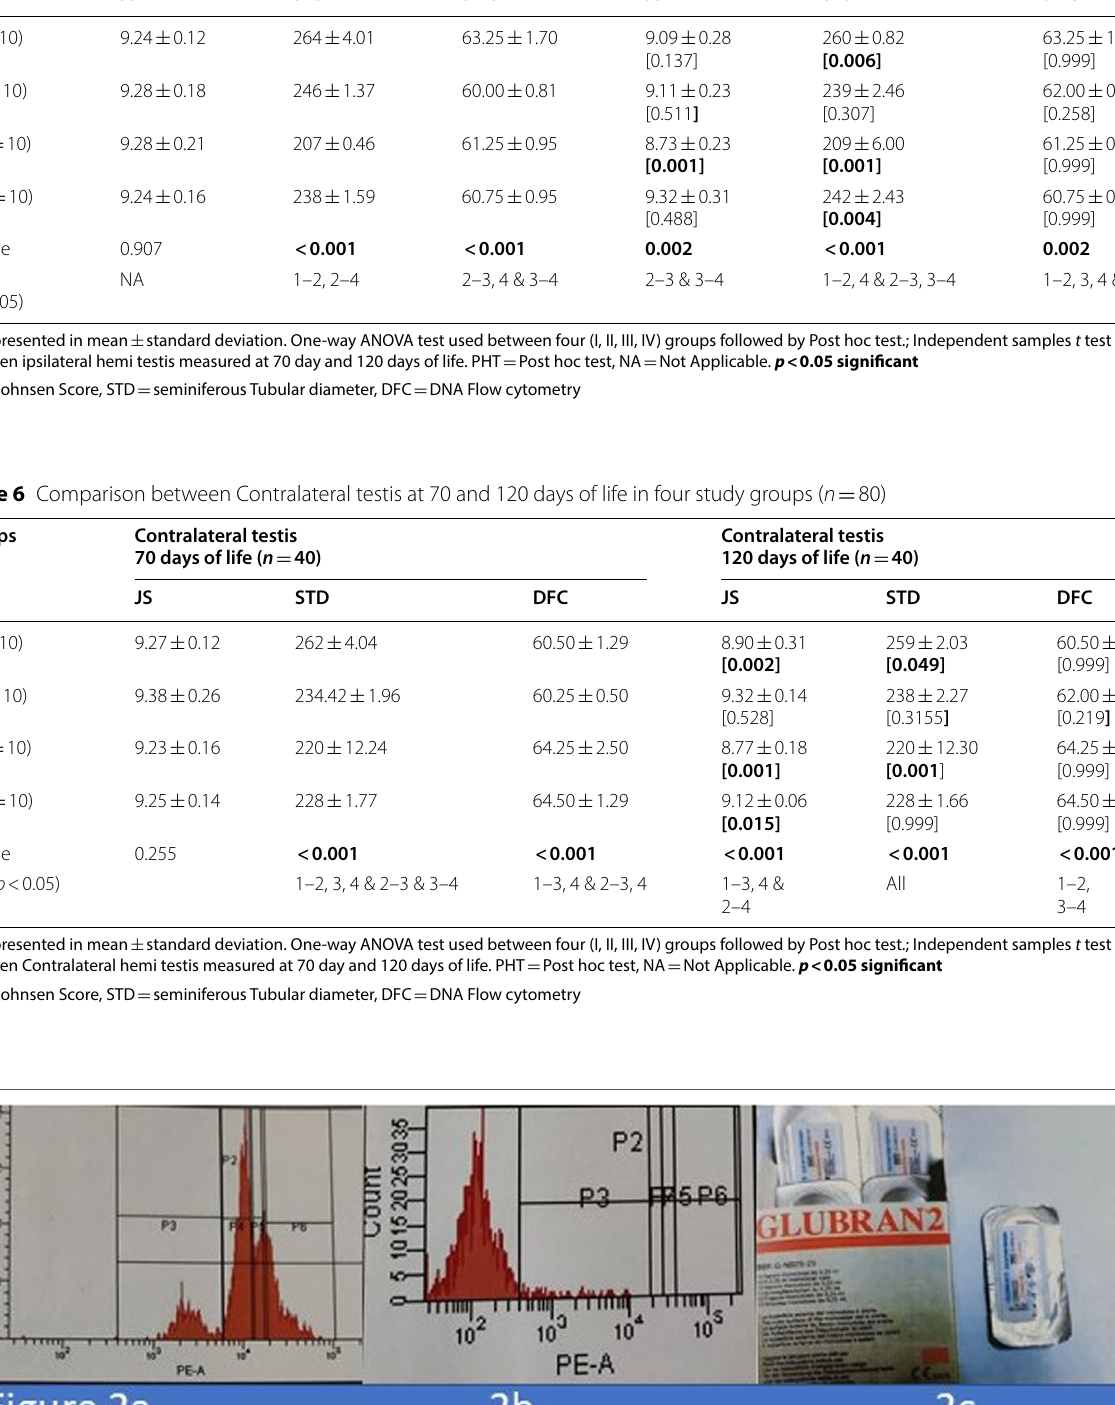
Table 5 Comparison between ipsilateral testis at 70 and 120 days of life of in four study groups